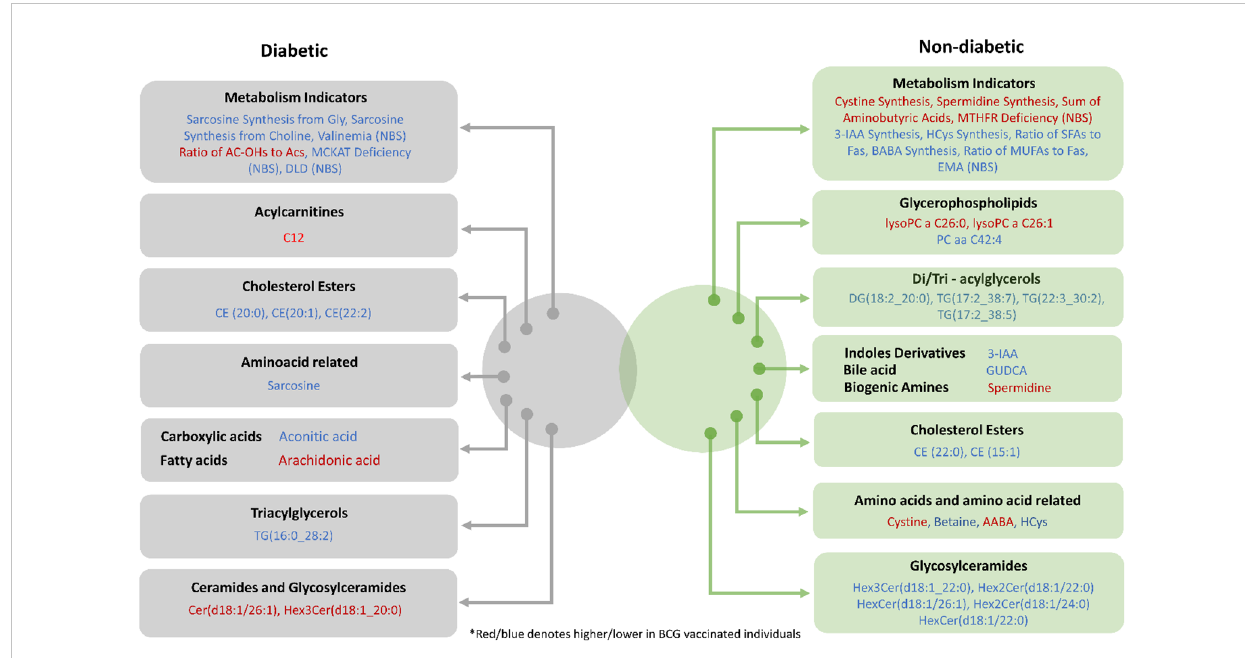
FIGURE 6 Venn diagram providing a snapshot of the BCG associated metabolites from diabetic and non-diabetic individuals with varying levels of COVID- 19